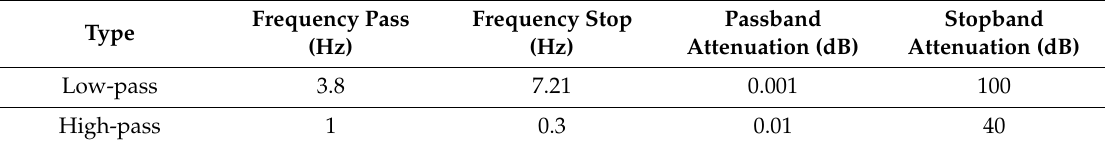
Table 1. Low-pass and high-pass filter design for the photoplethysmgraphic (PPG) raw signal.